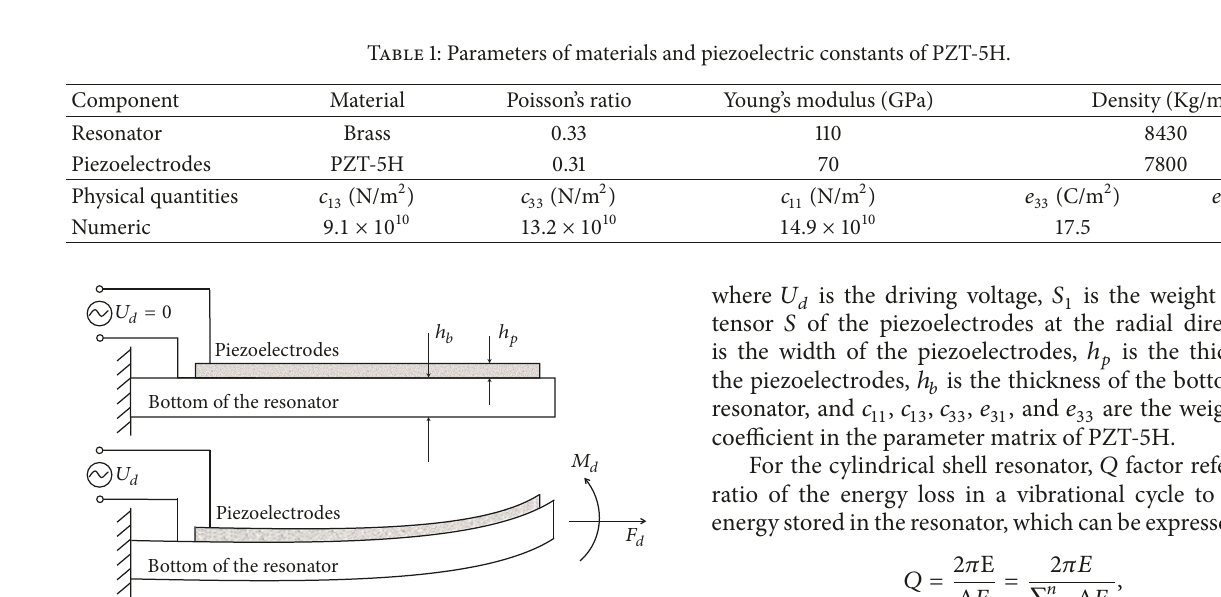
Figure 1: Schematic diagram of